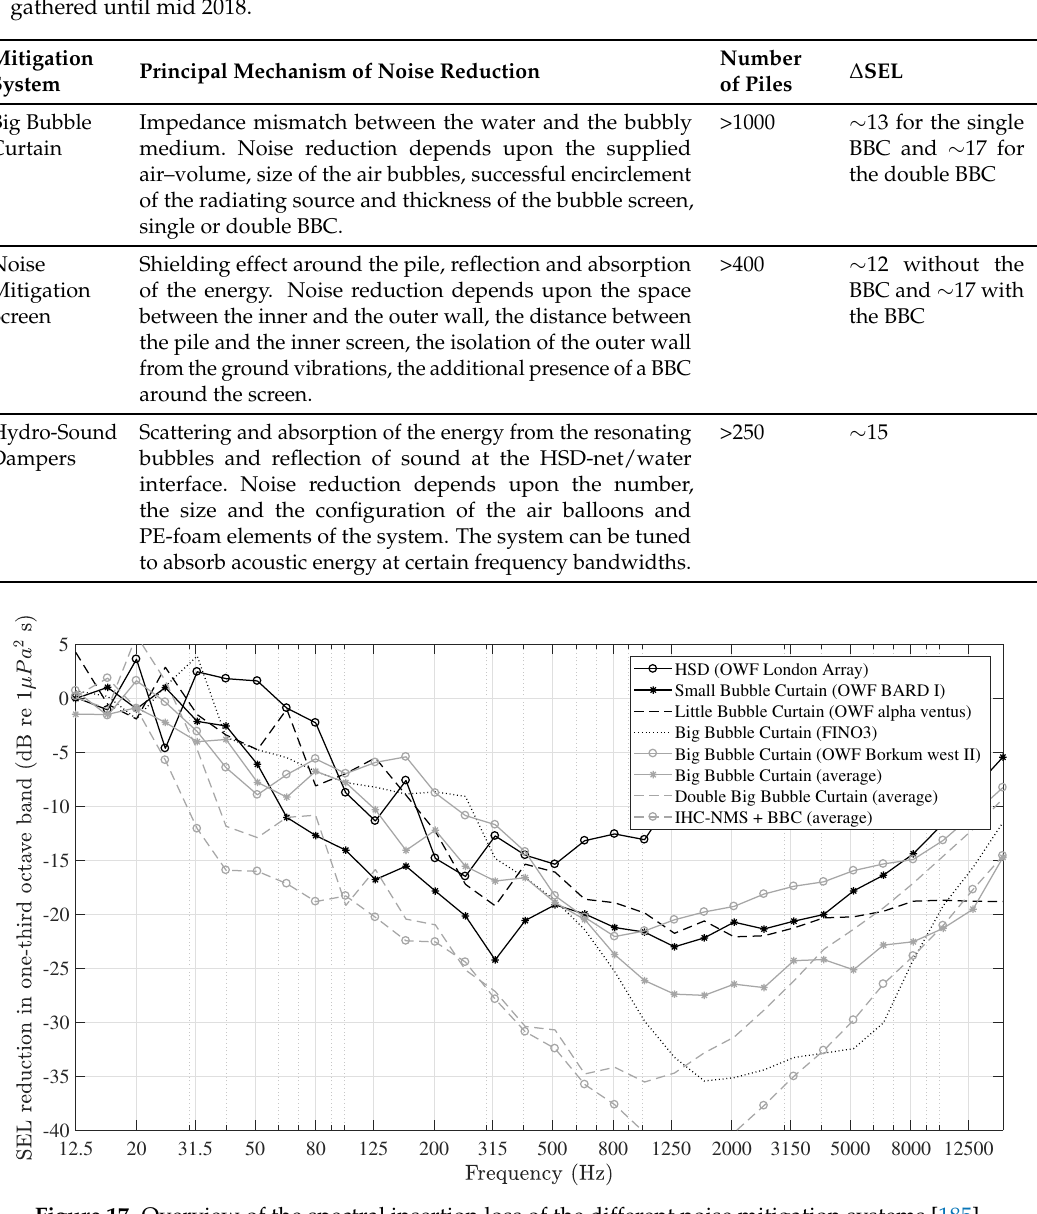
Figure 17. Overview of the spectral insertion loss of the different noise mitigation systems